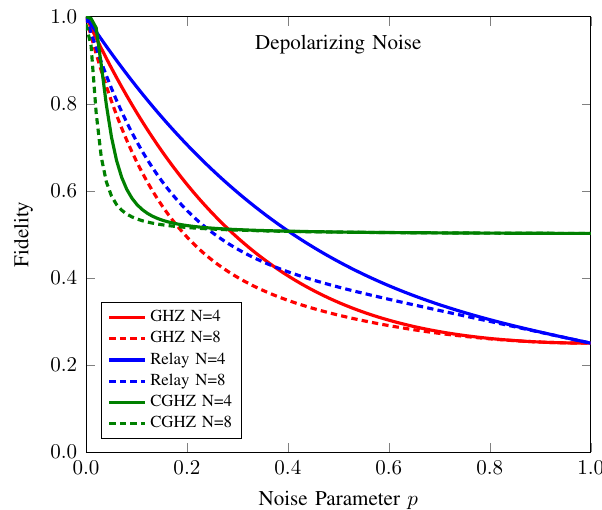
Figure 7. Fidelity of anonymous entanglement of CAQT compared to those of conventional GHZ- based AQT and relay-based AQT under depolarizing noise. Here, the dotted (solid) line denotes the fidelity of anonymous entanglement when the number of participants N is 4 (8). The fidelity values of the anonymous entanglement of conventional GHZ-state-based AQT (GHZ), relay-based AQT (Relay), and our counterfactual GHZ-state-based AQT (CGHZ) are represented by the red, blue, and green lines, respectively.